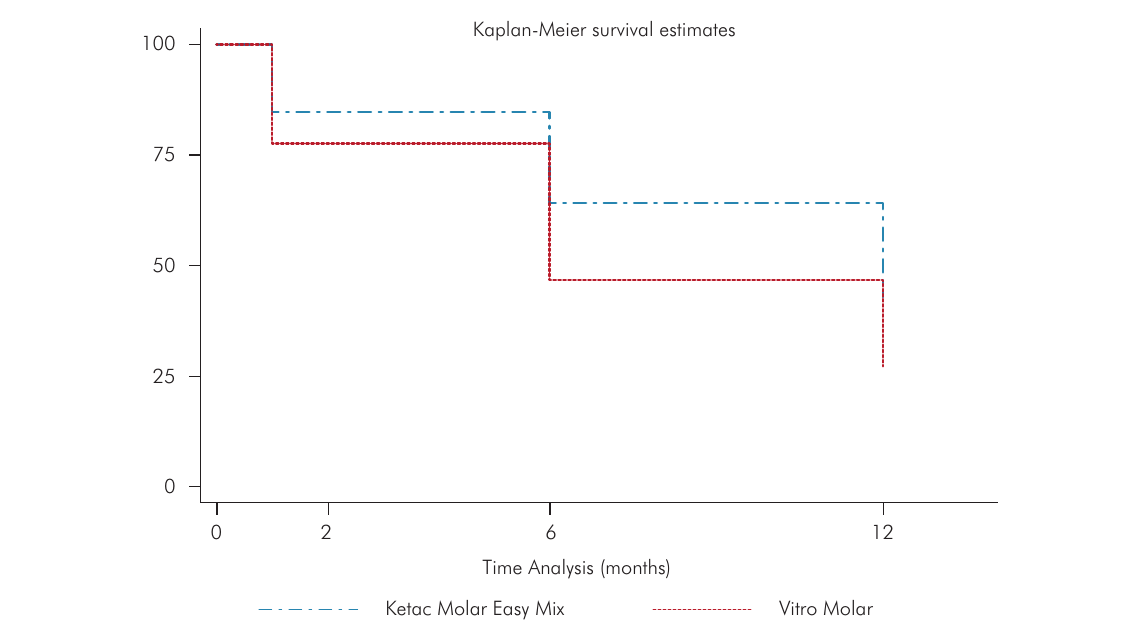
Figure 2. Kaplan–Meier survival estimates among the materials for occlusoproximal restorations in primary teeth (log–rank p =